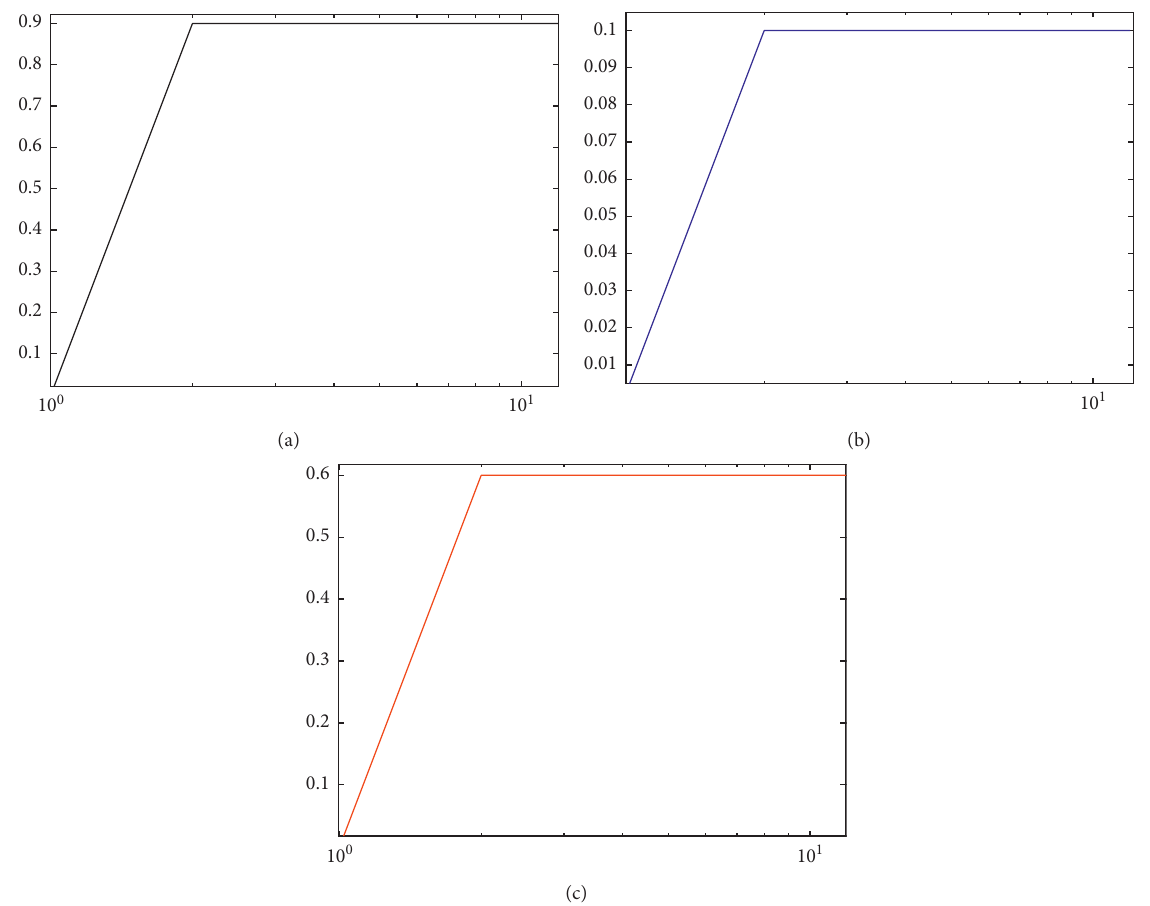
Figure 10: The evolution of all controls u